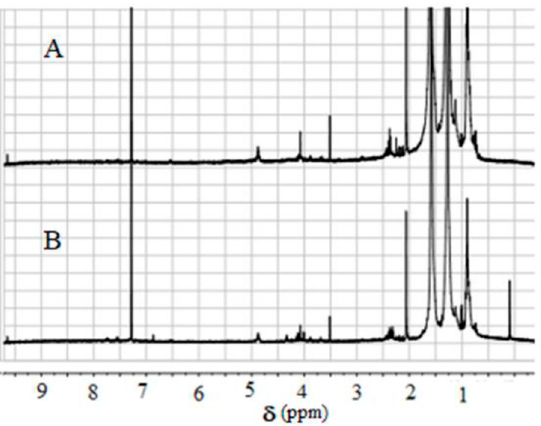
Figure 2. 1 H ‐ NMR spectra of solid phase CDCl 3 extract of untreated (US) ( A ) and pre ‐ treated (AS) Figure 2. 1 H-NMR spectra of solid phase CDCl 3 extract of untreated (US) ( A ) and pre-treated (AS) ( B ) samples. ( B ) samples.